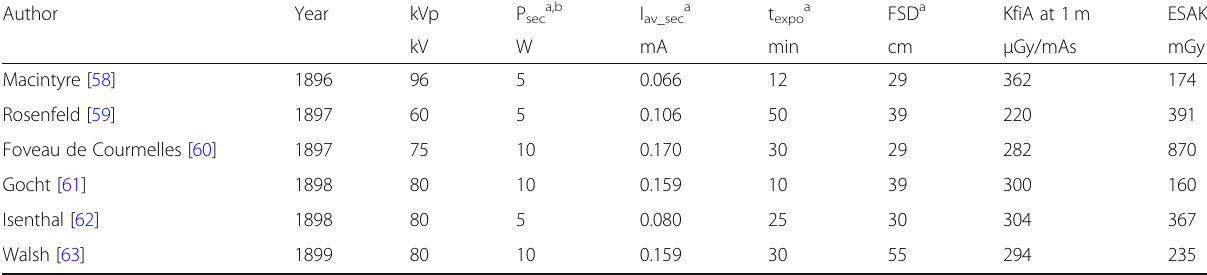
Table 5 Some exposure parameters from before 1900 and the corresponding ESAK